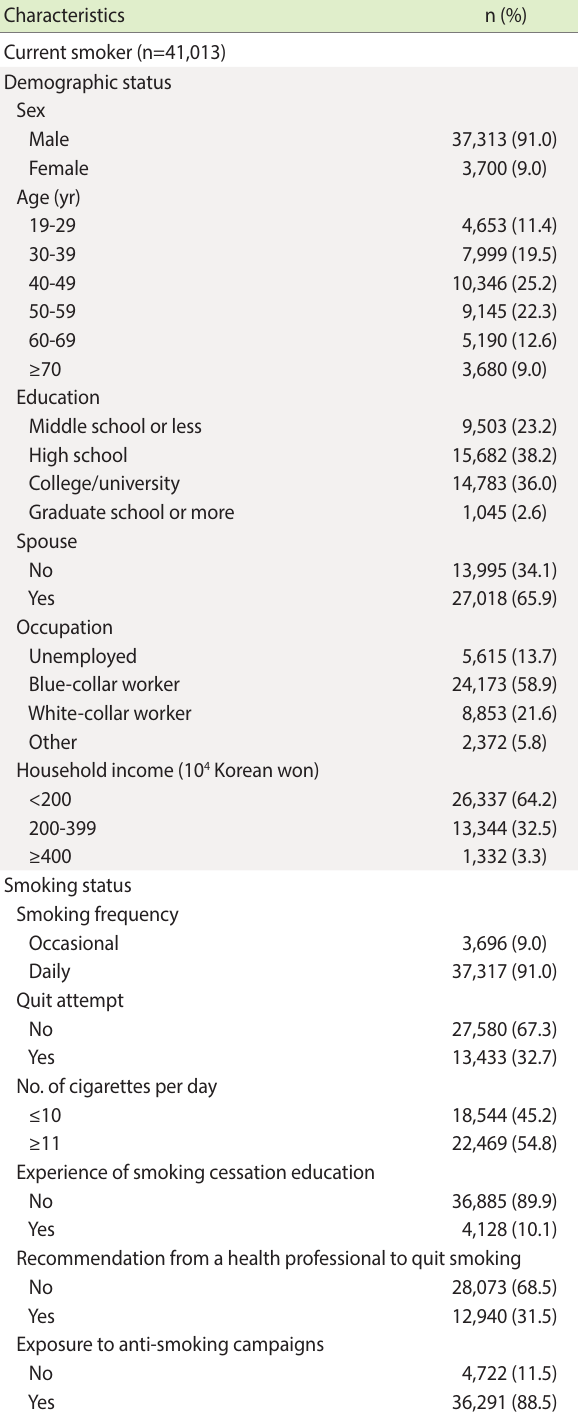
Table 1. General characteristics of the study subjects